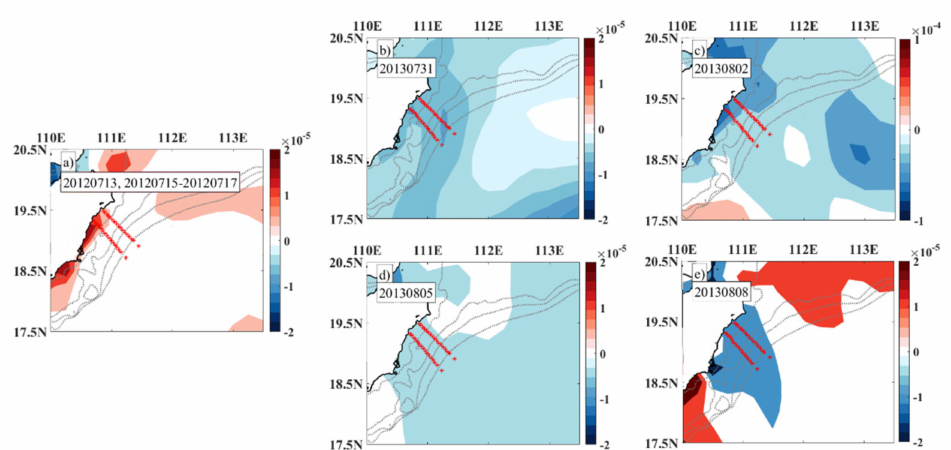
Figure 13. The Ekman pumping (m/s) in the case without the typhoon on 13 and 15–17 July 2012 ( a ), before the typhoon on 31 July 2013 ( b ), during the typhoon on 2 August 2013 ( c ), and after the typhoon on 5 ( d ) and 8 August 2013 ( e ). Red starts represent observation stations in the two sections H and F. Gray lines represent iso-baths of 50, 100, 150, and 200